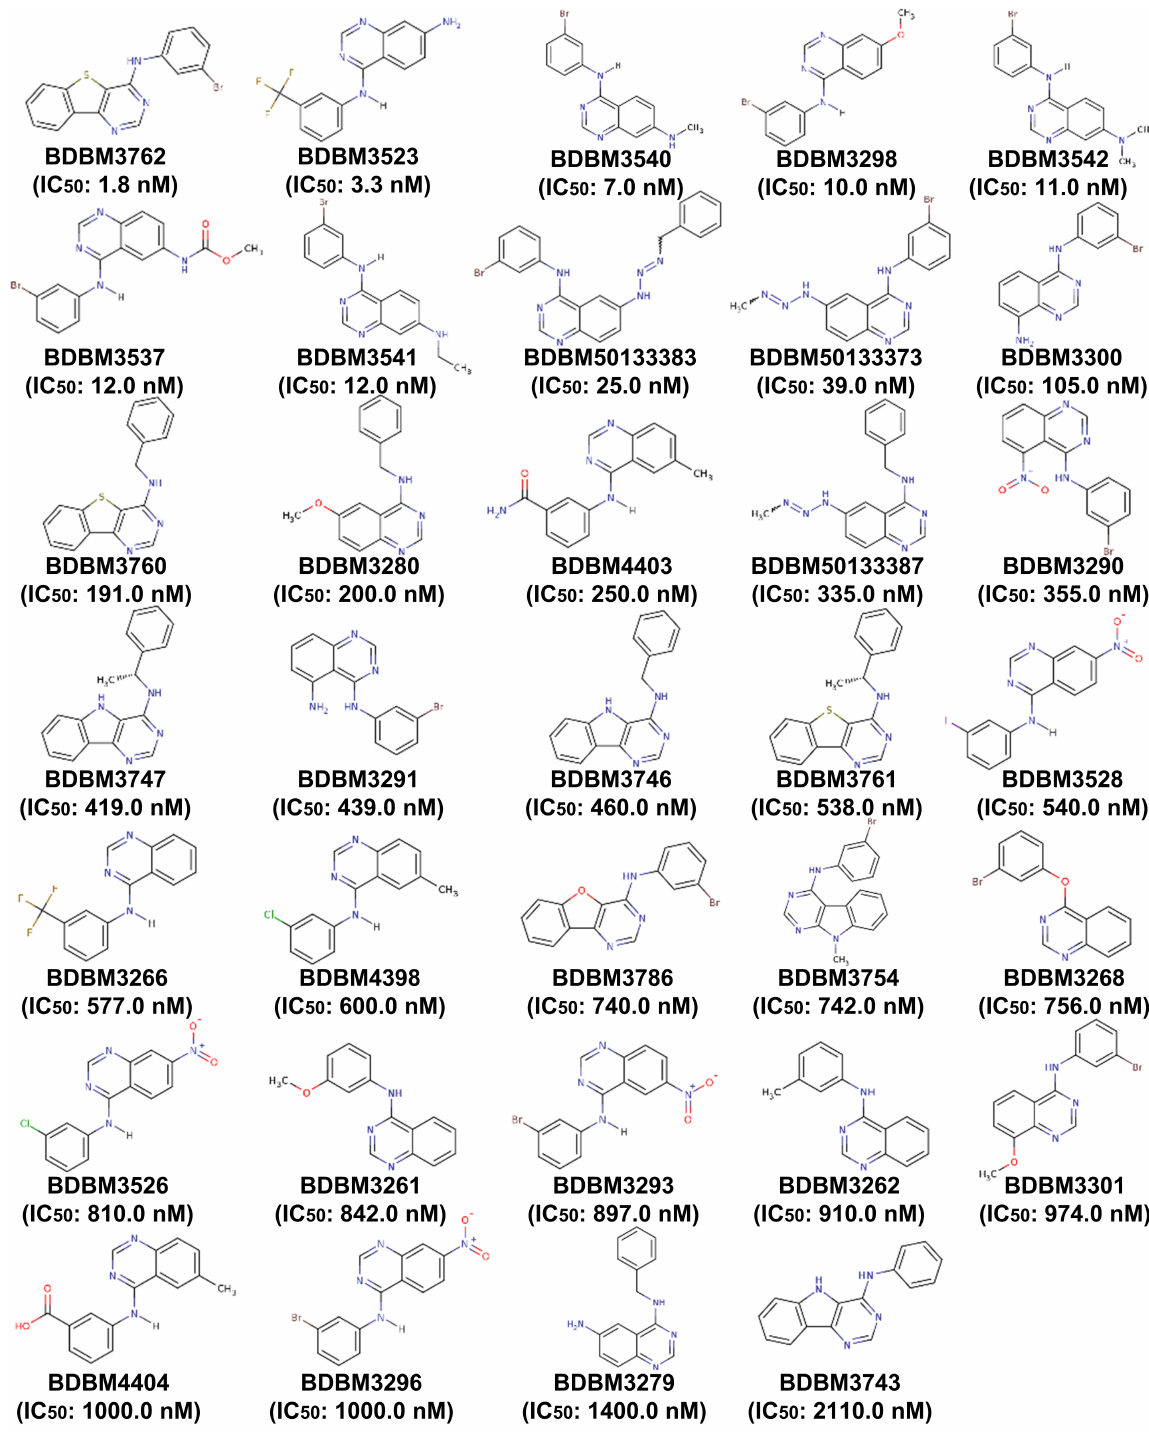
Figure A2. The structures of 34 structurally diverse compounds comprising the test set used to evaluate the validity of the 3D QSAR pharmacophore model.